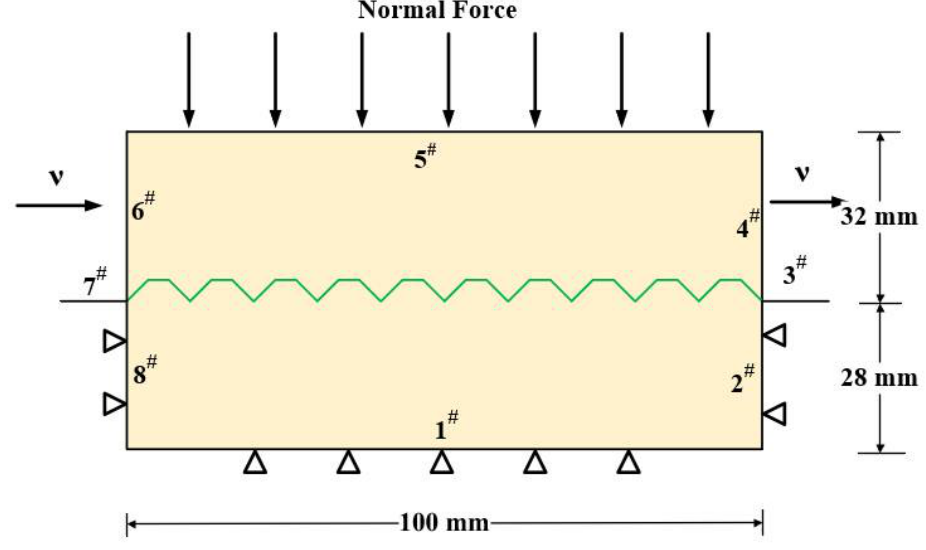
Figure 2. Numerical model for shear tests on dentate joints (“ # ” indicates wall number).